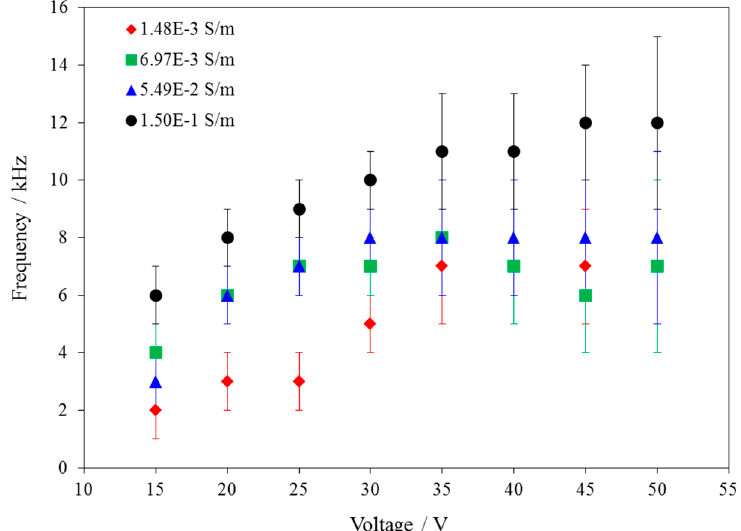
Figure 3. The required mean maximum frequency and voltage for hydrogel polymerization using PEGDA solutions with different polymer solution electrical conductivities. This plot indicates that as the electrical conductivity of the solution increases or the applied voltage increases, the frequency required for hydrogel polymerization also